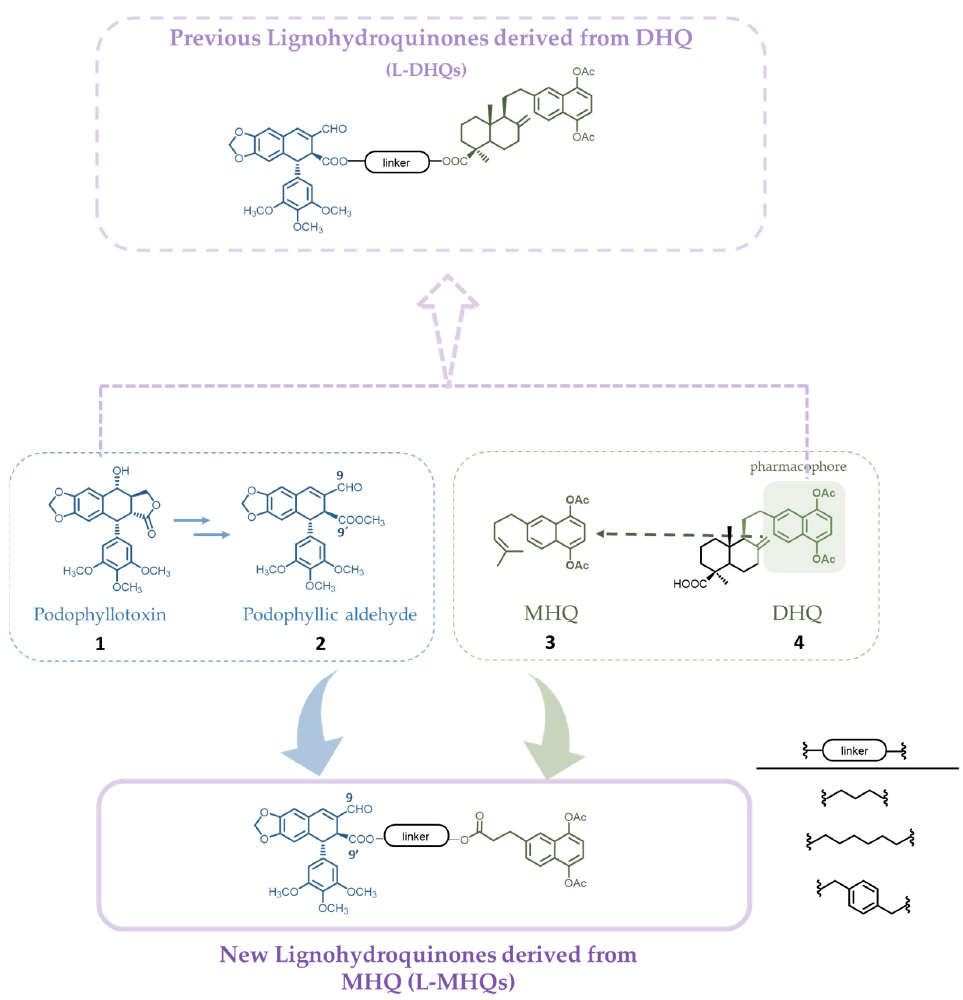
Figure 2. Schematic representation of the design of the new simplified hybrids lignomonoterpenylnaphthohydroquinones (L-MHQs), from cyclolignans ( 1 and 2 ) and monoterpenylnaphthohydroquinones (MHQ 3 ) as a simplified model of diterpenylnaphthohydroquinones (DHQ 4 ).